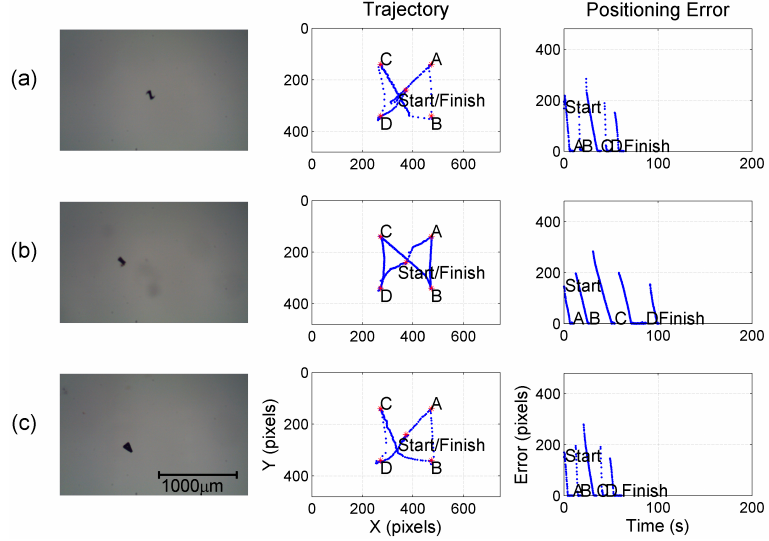
device converges on the target